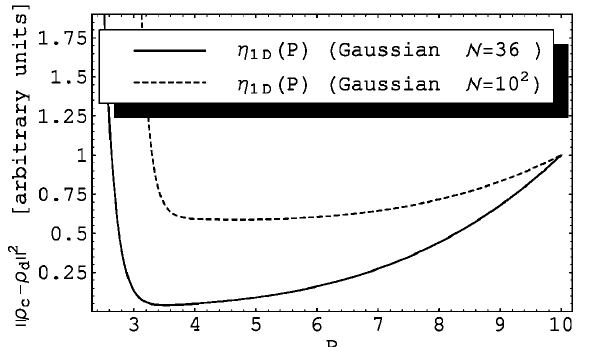
(cid:4) P (cid:5) as defined in Eq. (68) for N (cid:6) 36 FIG. 5. Plots of / 1D and N (cid:6) 10 2 (corresponding in 3D to N 3 (cid:2) 5 (cid:11) 10 4 and N 3 (cid:6) 10 6 macroparticles). Macroparticles are equally spaced and have a different normalization to reproduce the macro- scopic distribution, which is assumed to be Gaussian. The functions have been normalized to 1 at the right